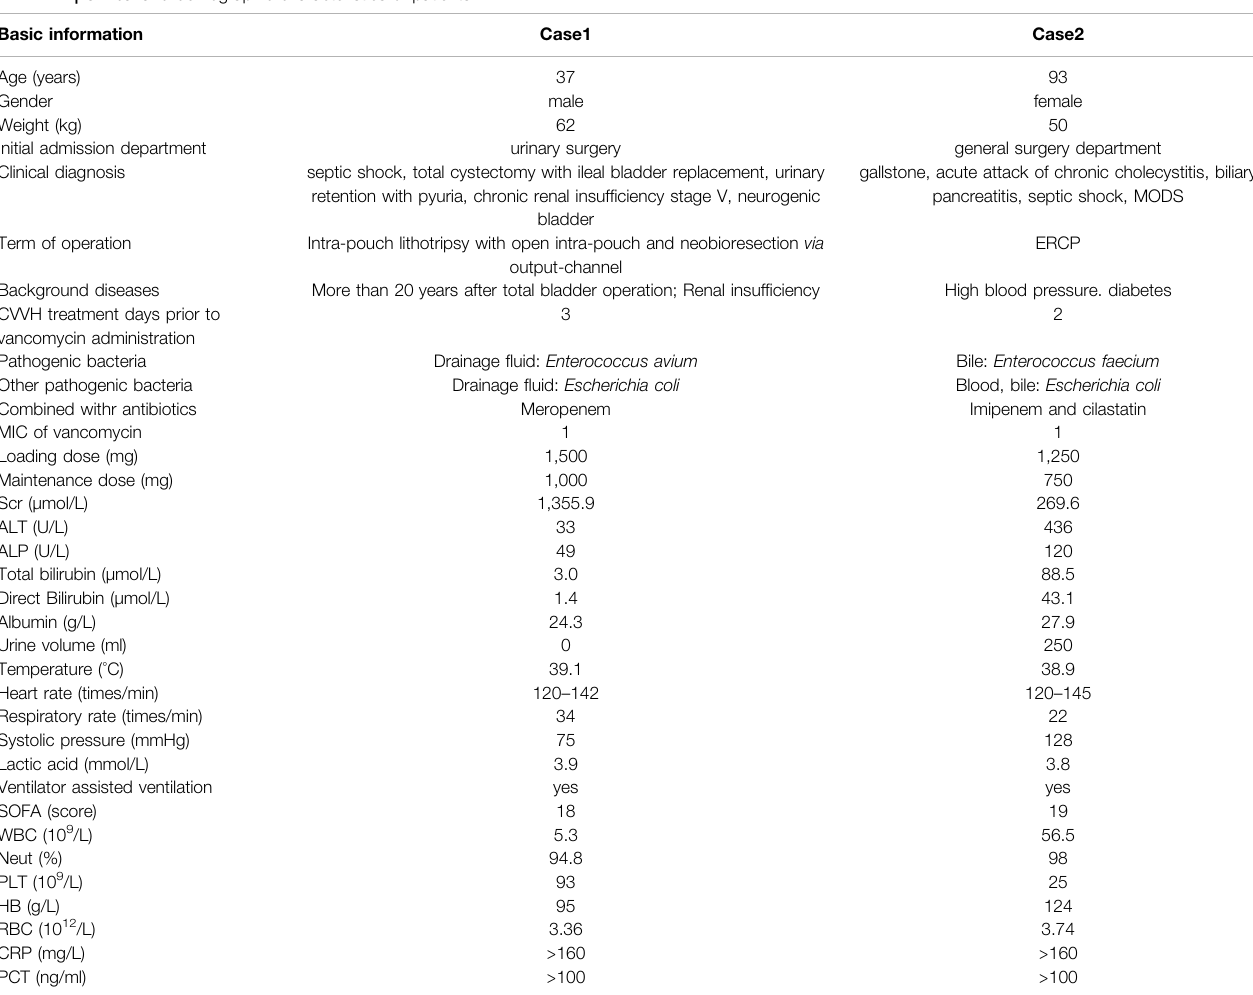
TABLE 2 | Clinical and demographic characteristics of patients a